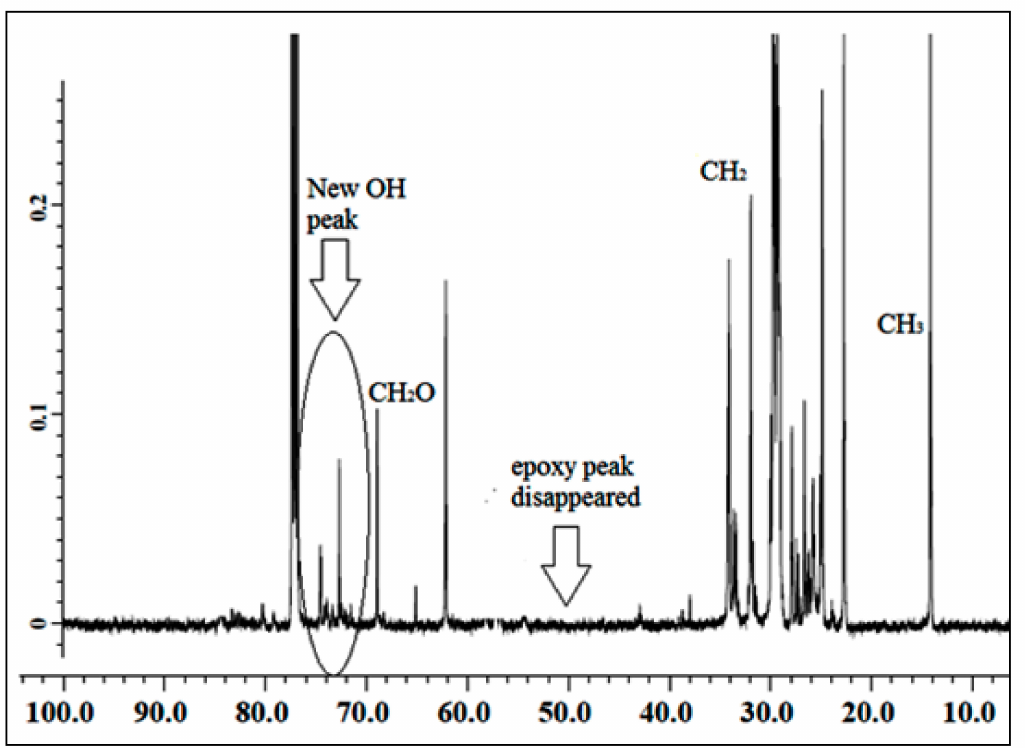
Figure 3. 13 C NMR spectrum of